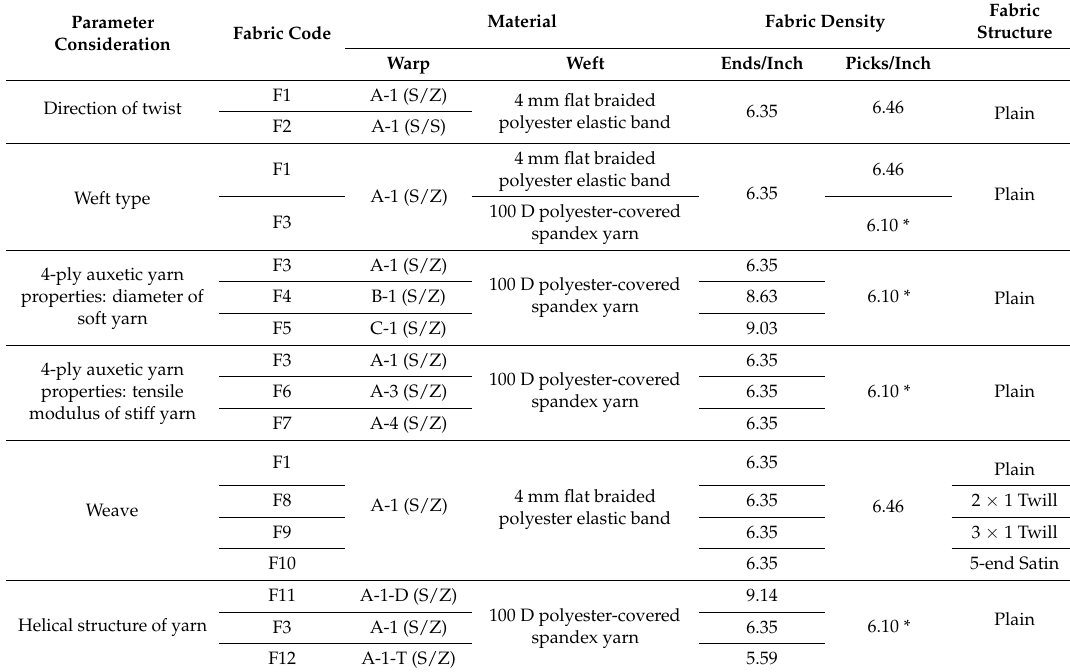
Table 2. Constructional characteristics of woven fabrics produced.